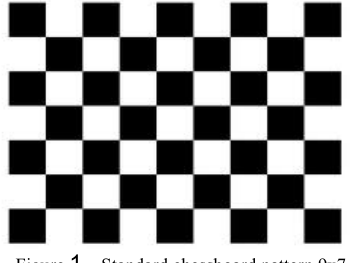
Figure 1 – Standard chessboard pattern